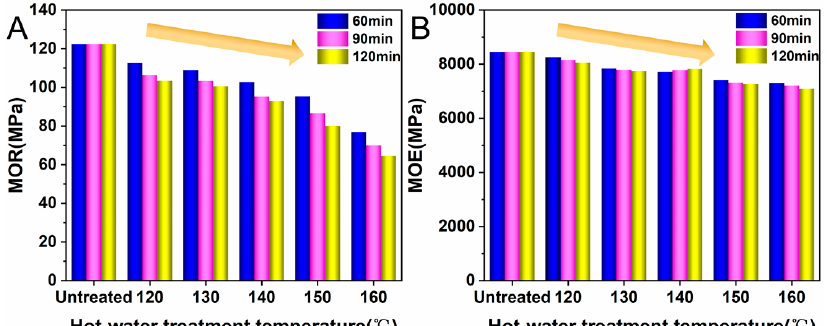
Figure 6. ( A ) Influence of different hydrothermal treatments on MOR of samples; ( B ) Influence of different hydrothermal treatments on MOE of samples.